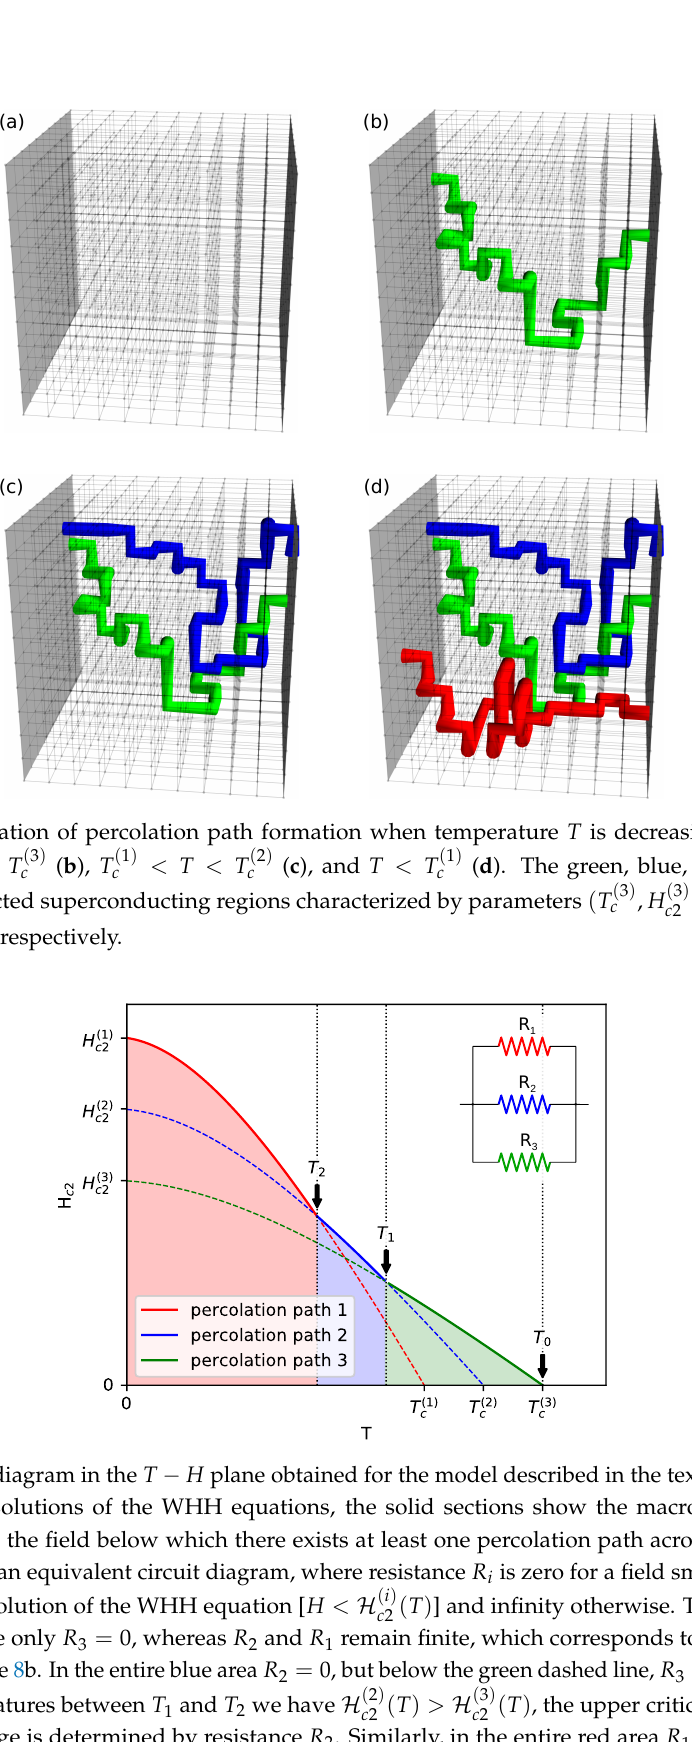
Figure 9. Phase diagram in the T − H plane obtained for the model described in the text. The dashed lines represent solutions of the WHH equations, the solid sections show the macroscopic upper critical field, i.e., the field below which there exists at least one percolation path across the sample. The inset shows an equivalent circuit diagram, where resistance R i is zero for a field smaller than the ( i ) ( T ) ] and infinity otherwise. The green area corresponding solution of the WHH equation [ H < H c 2 is a region where only R 3 = 0, whereas R 2 and R 1 remain finite, which corresponds to the situation depicted in Figure 8b. In the entire blue area R 2 = 0, but below the green dashed line, R 3 = 0. However, ( 2 ) ( T ) > H ( 3 ) ( T ) , the upper critical field in this since for temperatures between T 1 and T 2 we have H c 2 c 2 temperature range is determined by resistance R 2 . Similarly, in the entire red area R 1 = 0, whereas ( 2 ) ( T ) and H < H ( 3 ) ( T ) , respectively, i.e., below the blue and green R 2 and R 3 vanish for H < H c 2 c 2 dashed